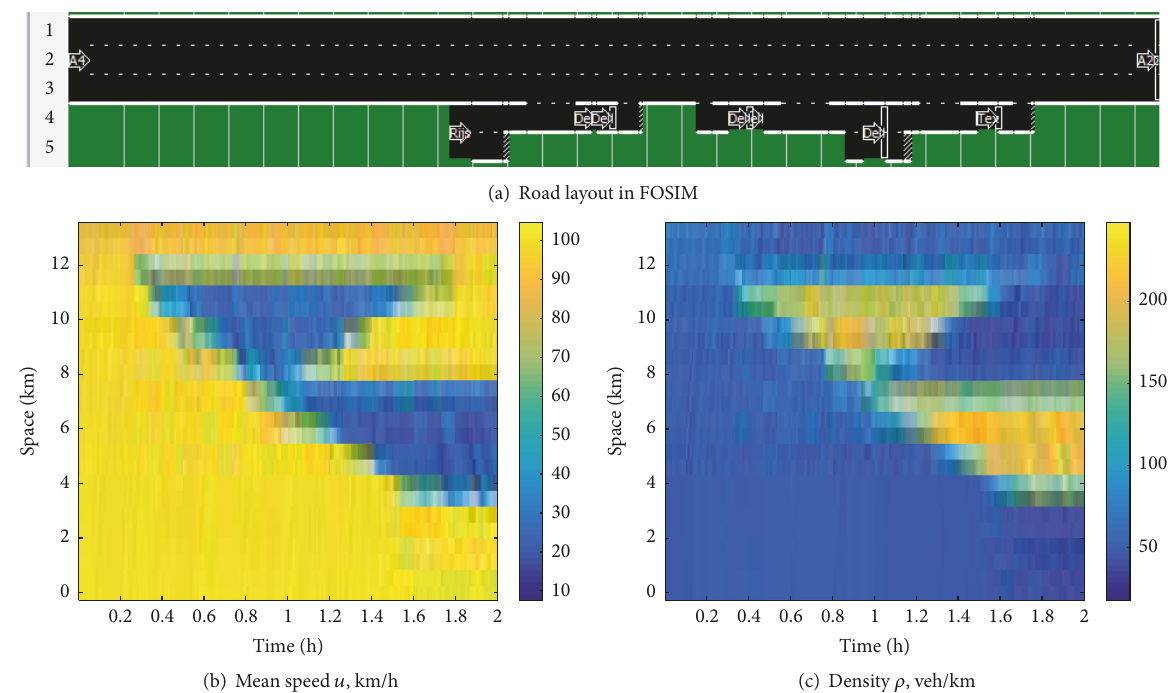
Figure 1: The schematized road stretch in FOSIM (a) and the true traffic conditions ((b) and (c)) in terms of the mean speed 𝑢 and density 𝜌 .